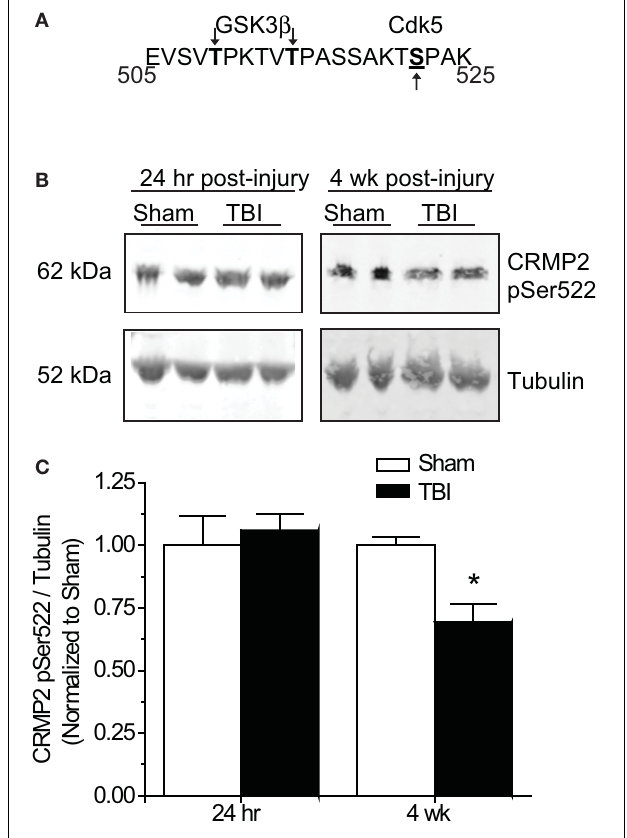
FIGURE 6 | Changes in CRMP2 phosphorylation by CDK5 following TBI. (A) Schematic of GSK3 β and Cdk5 phosphorylation sites within the rat CRMP2 sequence. Numbers represent amino acid residues within the CRMP2 sequence. (B) Western blots of CDK5-phosphorylared CRMP2 from hippocampal tissue 24h and 4 weeks following TBI. (C) Summary of CRMP2 pSer522 levels at both 24h and 4 weeks following TBI. For ease of comparison, data was normalized to the sham conditions. Levels of CRMP2 pSer522 were decreased at 4 weeks, but not 24h following TBI. ( ∗ p < 0 . 05, student’s t -test) (values represent mean ± s.e.m. from n =